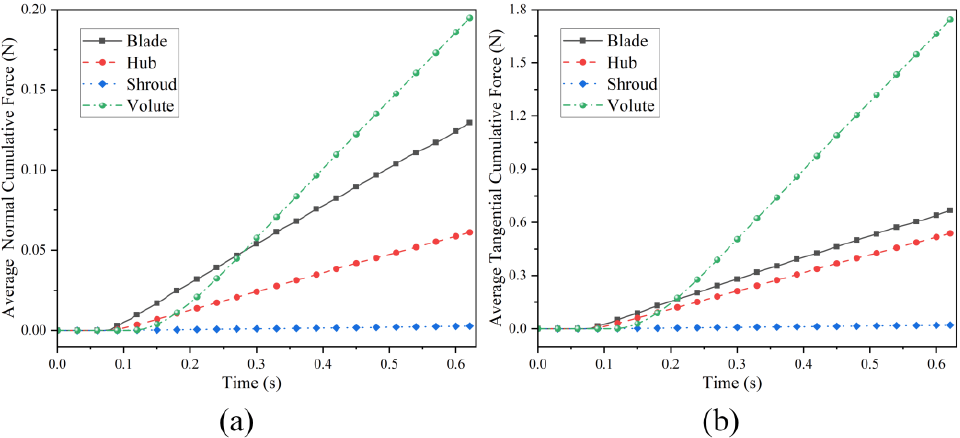
Figure 18. Variation in the average cumulative contact force for different components: ( a ) normal cumulative contact force; ( b ) tangential cumulative contact force.